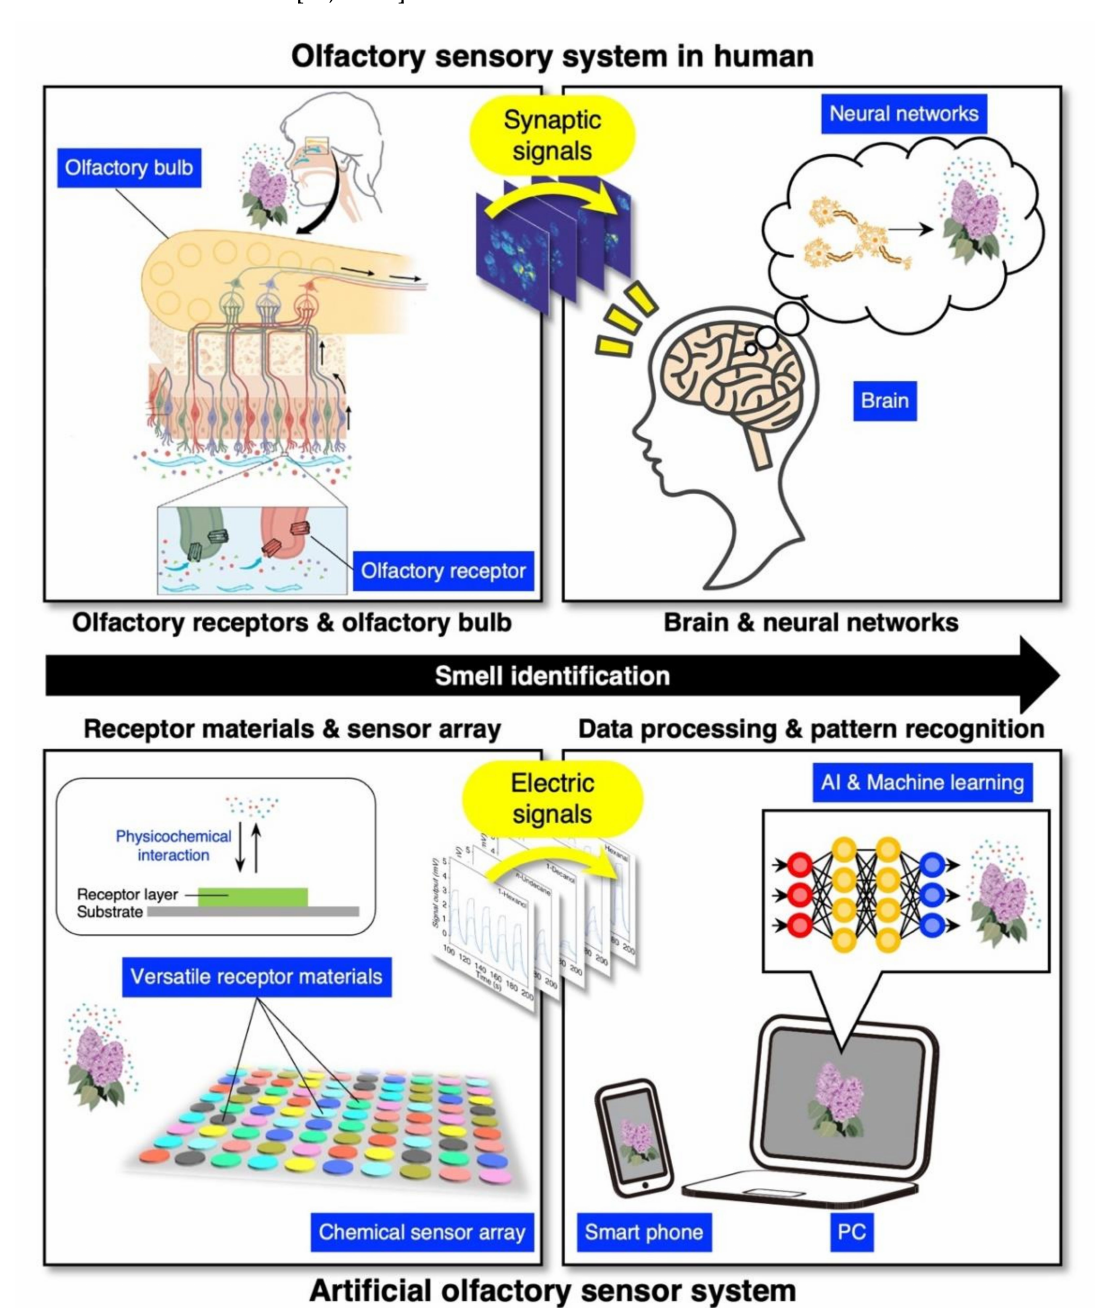
Figure 1. Schematic illustrations of olfactory sensory system in human and artificial olfaction system. Part of images are reprinted with permission from Ref. [22], Copyright 2007, European Molecular Biology Organization; and from Ref. [23], the authors licensed under CC-BY